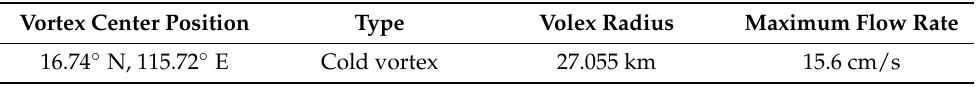
Table 1. Mesoscale vortex information extracted by the OW